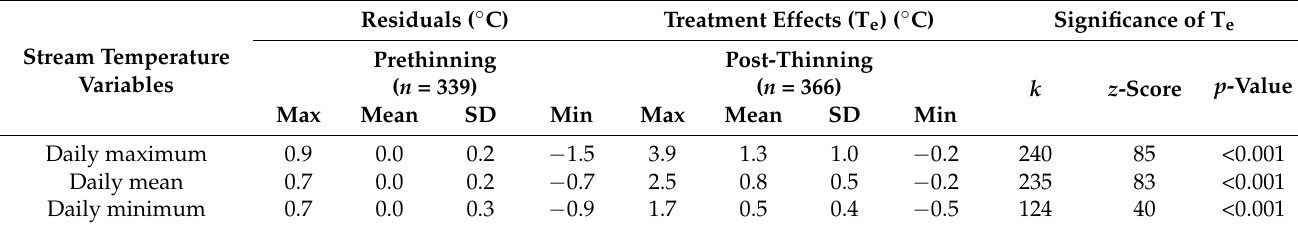
Table 3. Summary of residuals of prethinning regression, treatment effects, and the significance of treatment effects.